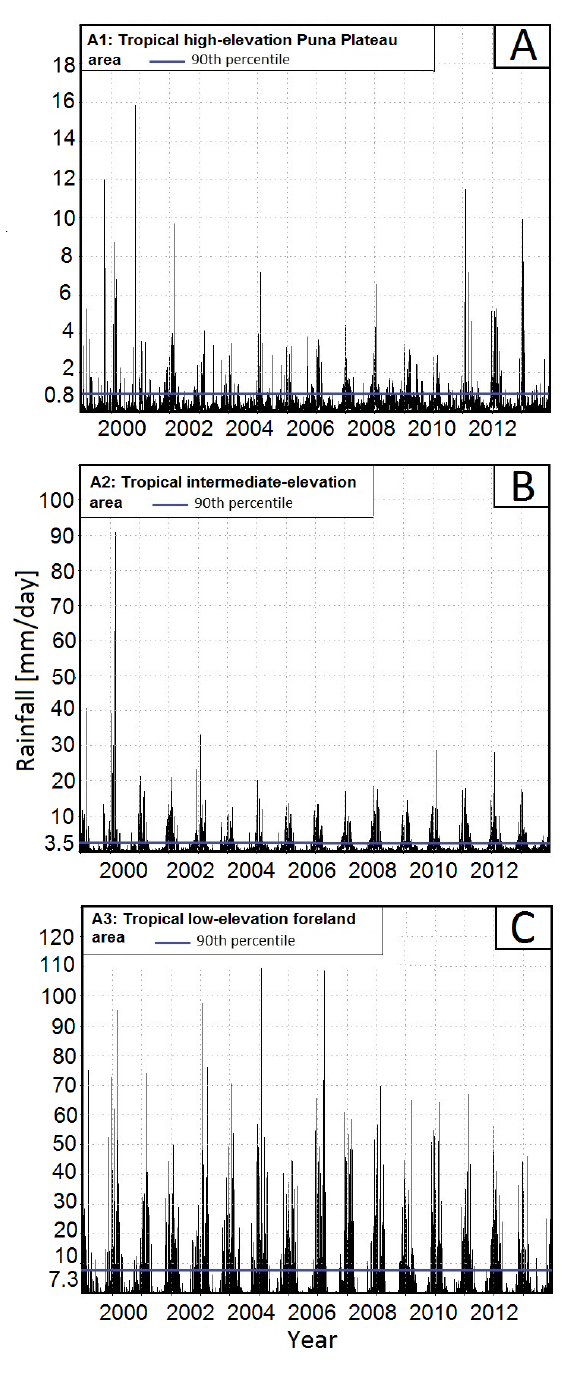
Figure 5. TRMM 3B42 rainfall time series data (1998–2013) over the boxes A1 ( A ), A2 ( B ) and A3 ( C ). The 90th percentile is shown by blue vertical line and varies from 0.8 mm/day on the high-elevation Puna Plateau, to 3.5 mm/day in the intermediate elevation and to 7.3 mm/day in the low-elevation foreland area. Note the different Y-axis